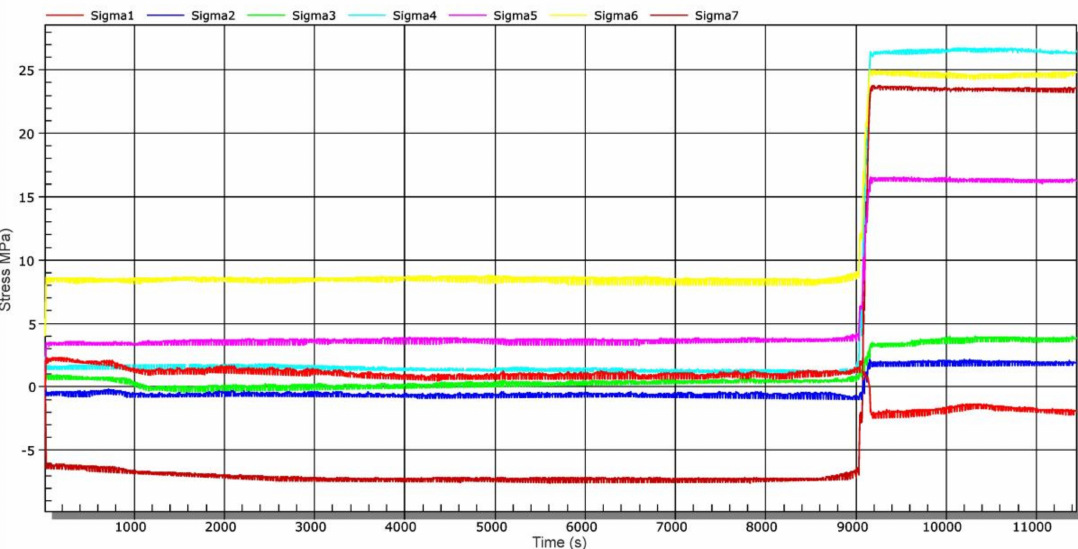
Figure 15. Time-dependent stress chart during water discharge from the water tunnel—stage 3.